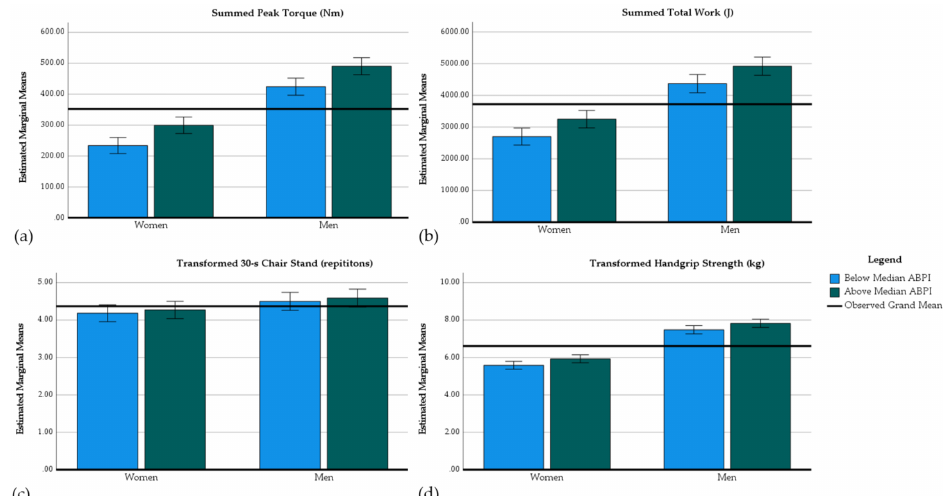
Figure 2. Animal-based protein intake and muscular performance. Animal-based protein intake was split at the median of percent energy from animal-based protein within both men and women; below median = 0, above median = 1. Covariates included age, gender, BMI, MVPA, relative energy intake, and percentages of energy intake from fat, carbohydrate, and protein. All bars are means, and error bars represent 95% confidence intervals. ( a ) Summed isokinetic peak torque by gender and animal-based protein intake. Summed isokinetic peak torque was calculated by adding the peak torques recorded during the isokinetic strength test, 60 ◦ per second for knee extension–flexion and 30 ◦ per second for plantar-dorsiflexion. ( b ) Summed isokinetic endurance by gender and animal- based protein intake. Summed isokinetic endurance was calculated by adding total work performed during a 21-repetition test at 180 ◦ per second for the knee extension–flexion and 60 ◦ per second for plantar-dorsiflexion. ( c ) Square root transformed 30-s chair stand test repetitions by gender and animal-based protein intake. The height of the chair for the 30-s chair stand test was 43 cm. ( d ) Square root transformed handgrip strength by gender and animal-based protein